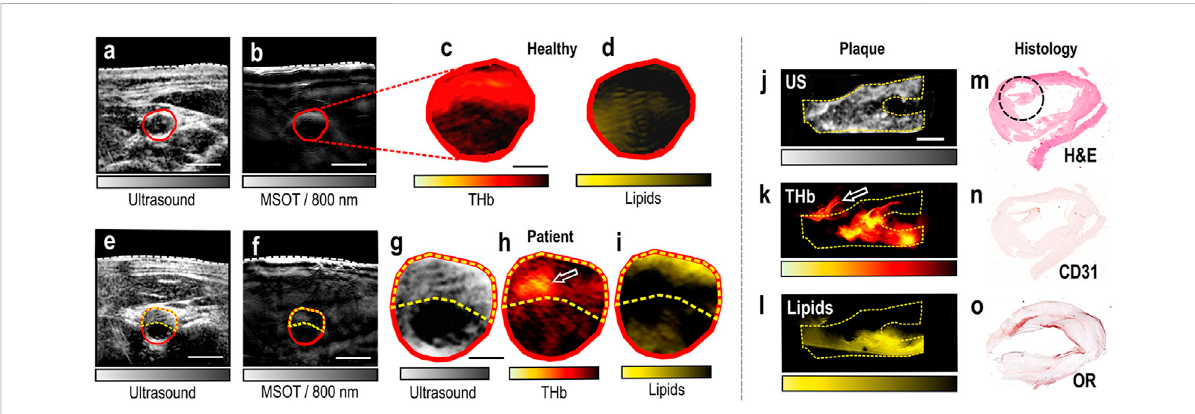
FIGURE 8 MSOT/USimagingofthecarotidarteryofahealthyvolunteerandapatient,MSOT/USimaging andhistologyofanexcised plaque. (A) USimage ofthetransverse sectionofthecarotid artery ofahealthyvolunteer. (B) CorrespondingMSOT imageat800 nm.White dashedline: skinsurface.The carotidlumenareaisdemarcatedinred.Scalebars:5 mm. (C) Magni fi cationofthelumen areaofthespectrallyunmixedMSOTimagein (B) showing the HbT signal. (D) Same magni fi cation showing the Lipids signal. Scale bar: 2.5 mm. (E) US image of a patient with carotid atherosclerosis. (F) Corresponding MSOT image at 800 nm. White dashed line: skin surface. The lumen is demarcated in red and the plaque area with a yellow dashed line. Scale bars: 5 mm. (G) Magni fi cation of the arterial cross-section in US. (H) Magni fi cation of the arterial cross-section of the spectrally unmixed MSOT image in (F) , showing the HbT signal. White arrow: region of increased HbT content. (I) Same magni fi cation showing the Lipids-signal. Scale bar: 2.5 mm. (J) Sagittal view of the excised plaque in US. (K) Same view of the plaque in corresponding unmixed HbT image. White arrow: postoperatively attached suture. (L) Same view of the plaque in unmixed MSOT Lipids image. Scale bar: 4 mm. (M) Histological view with H&E staining. The black circle shows a region with thrombotic and erythrocytes components. (N) Histological view with CD31-staining targeting the neovascularization. (O) Histological view with OR-staining showing the lipid content of the plaque. MSOT: multispectral optoacoustic tomography;